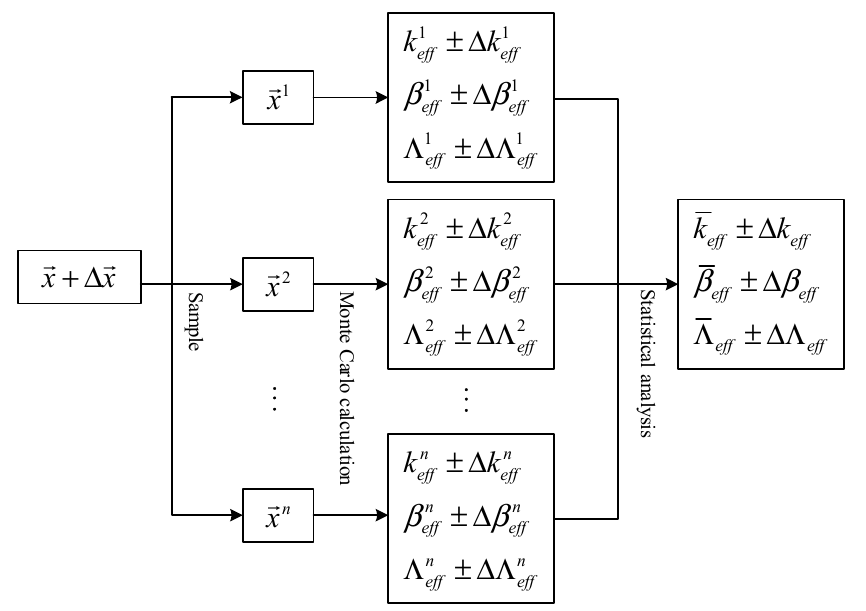
Figure 1. Flow chart of stochastic sampling method.